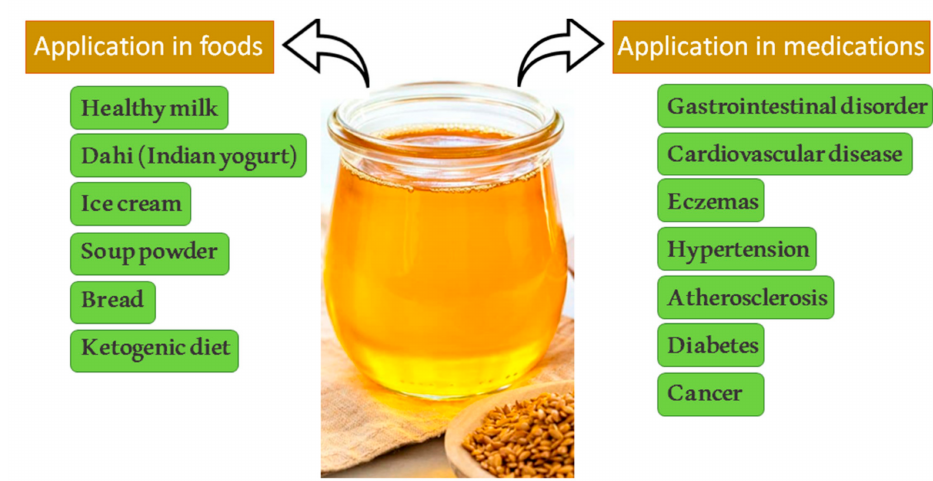
Figure 2. Applications of flaxseed oil in different food matrixes and biopharmaceuticals for the